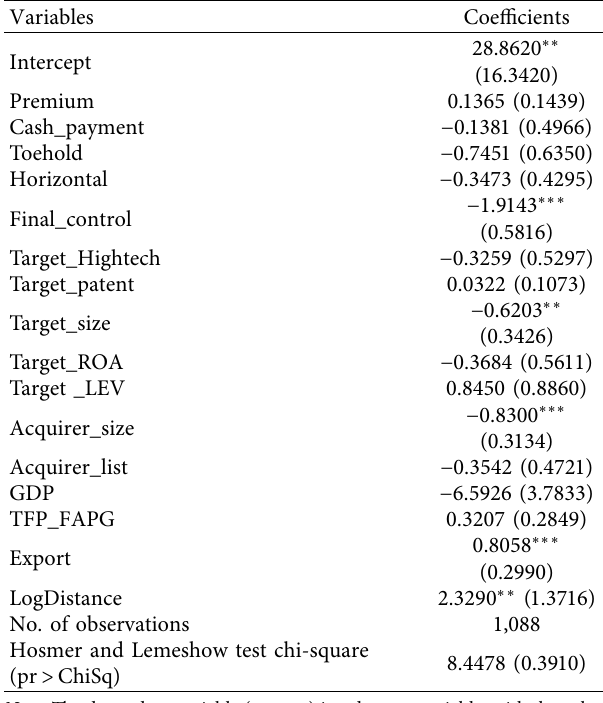
Table 3: Logistic regression results in the probability of acquisition